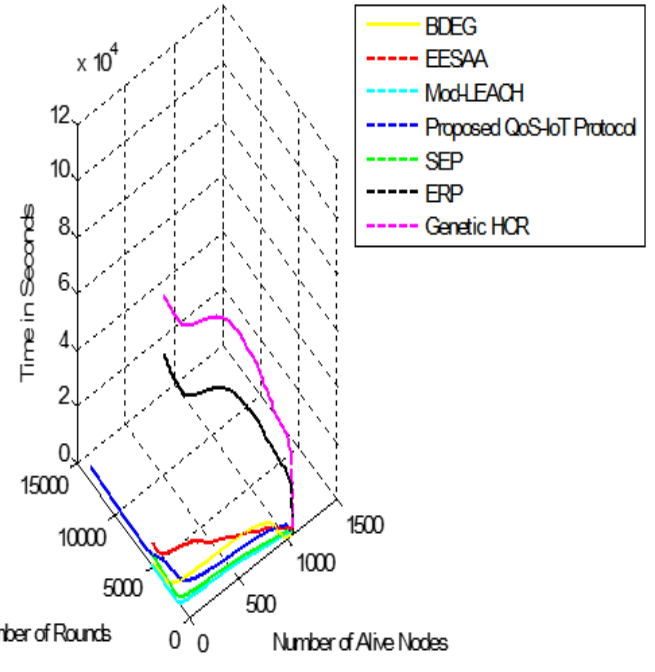
Figure 4. Network lifetime in reference to the remaining energy of nodes.